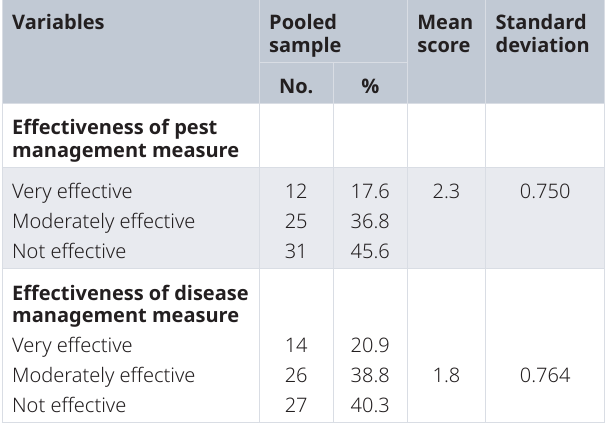
Table 10. Rating of the level of effectiveness of pests and disease management practices.